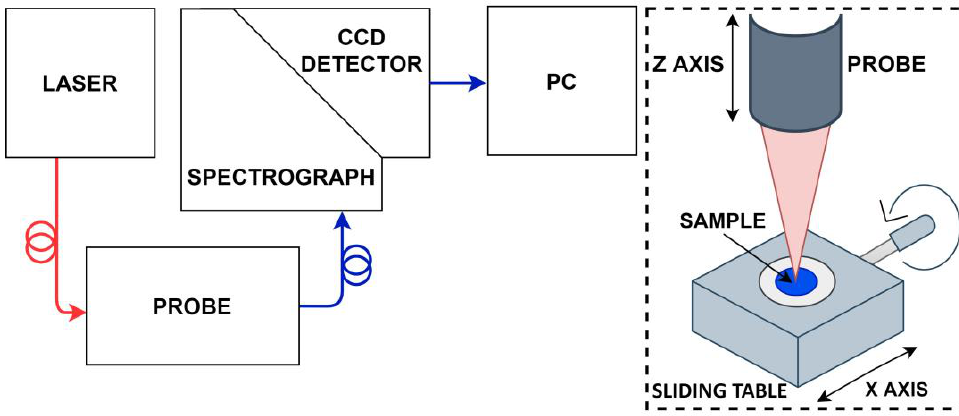
Figure 1. The scheme of the Raman measurement system. The block diagram of the system is shown on the left and the probe scheme and the sample holder on the